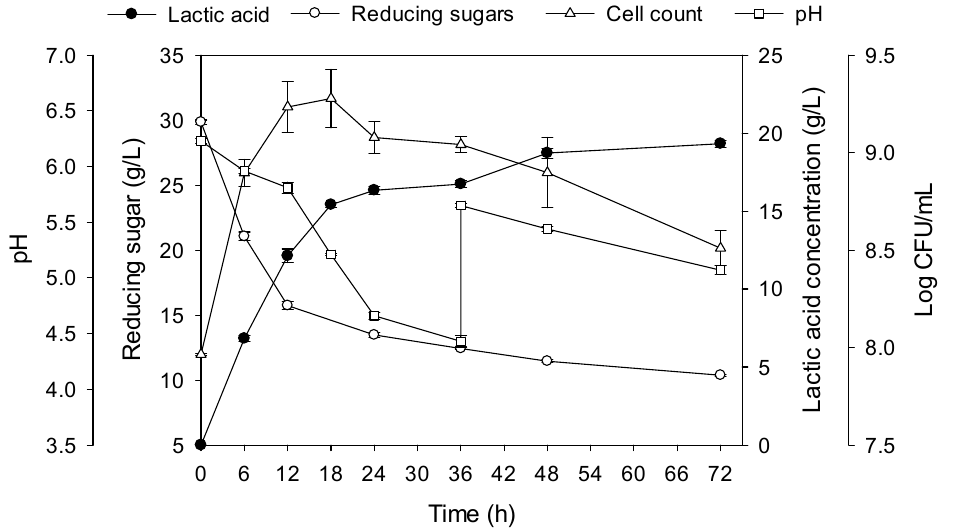
Figure 1. Lactic acid fermentation of Gracilaria sp. hydrolysate by lactic acid bacteria strains BCRC 10695 and 12327. 3% ( v / v ) of the Lb. acidophilus (BCRC 10695) and Lb. plantarum (BCRC 12327) were inoculated and the fermentation were accomplished at 30 °C for 72 h. Each value is mean ± standard deviation ( n = 3).